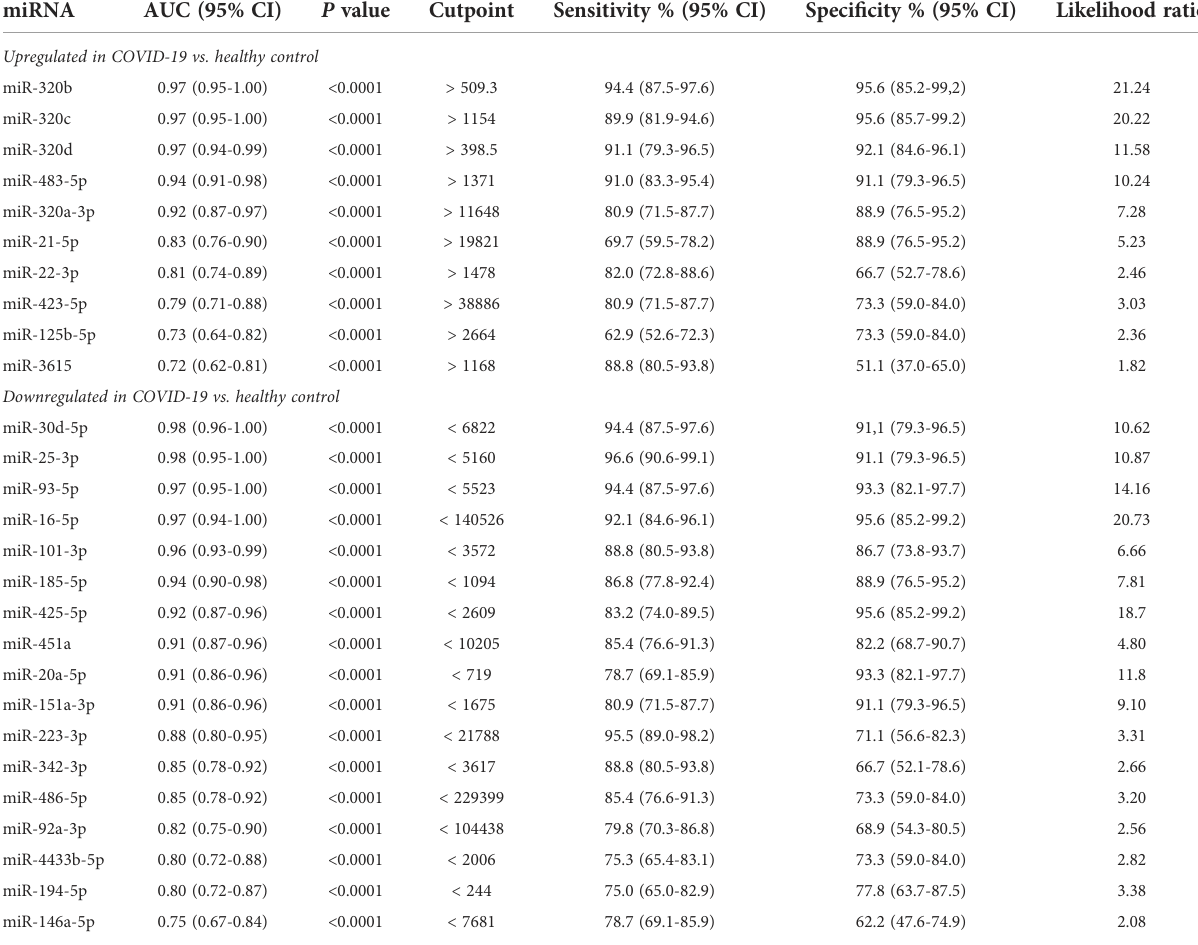
TABLE 2 ROC curve analysis of differentially expressed serum microRNAs in COVID-19 patients vs. healthy controls. miRNA AUC (95% CI) P value Cutpoint Sensitivity % (95% CI) Speci fi city % (95% CI) Likelihood ratio Upregulated in COVID-19 vs. healthy control